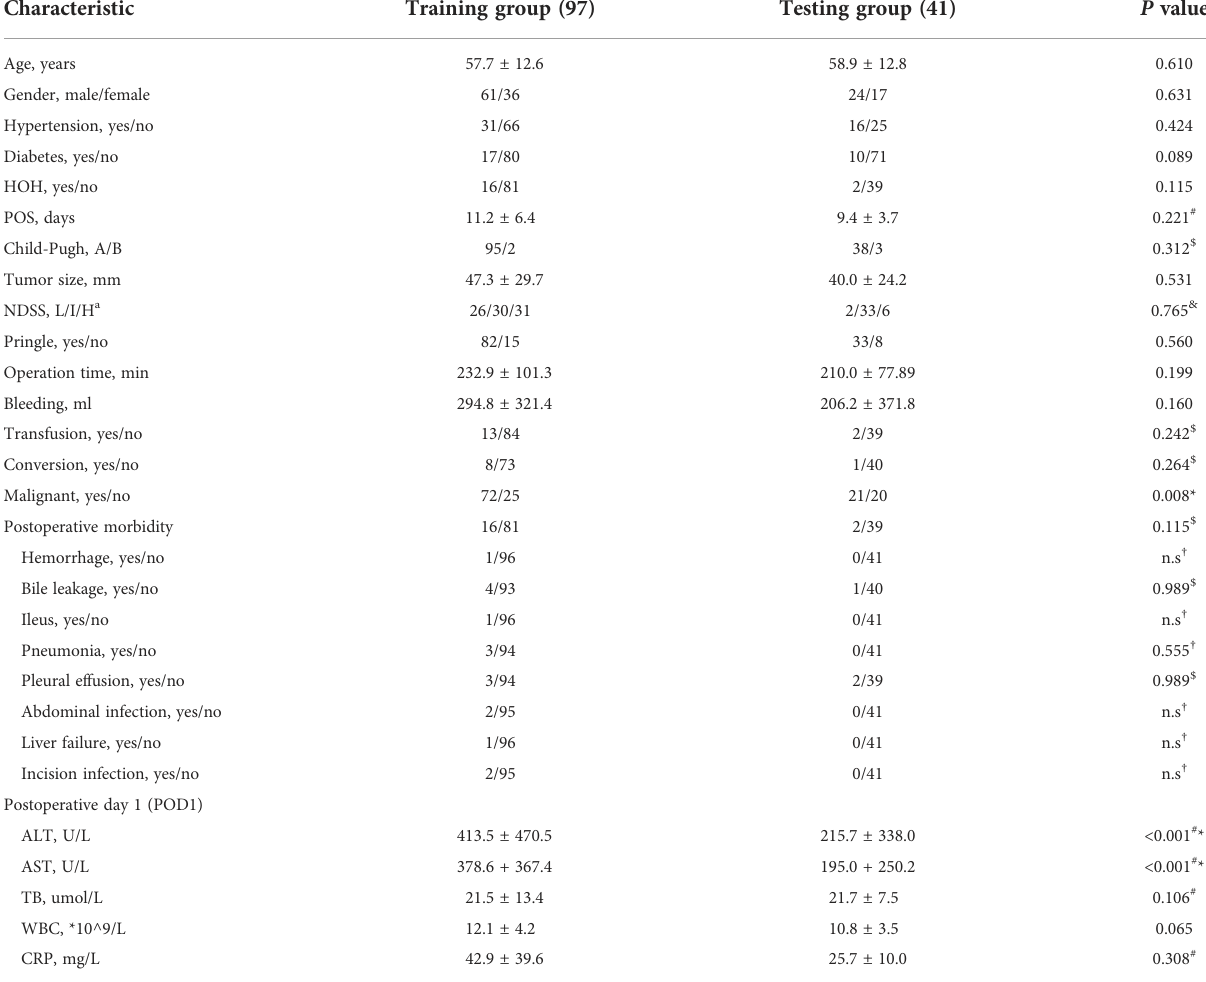
TABLE 5 Patient characteristics and surgical outcomes of LLR between Training and Testing cohorts.